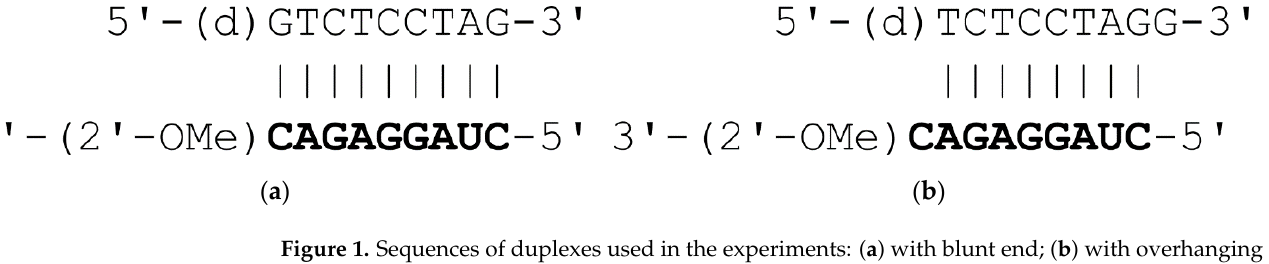
Figure 1. Sequences of duplexes used in the experiments: ( a ) with blunt end; ( b ) with overhanging ends. Characters in normal format mean DNA, bold characters are 2′ - O -methyl-RNA.